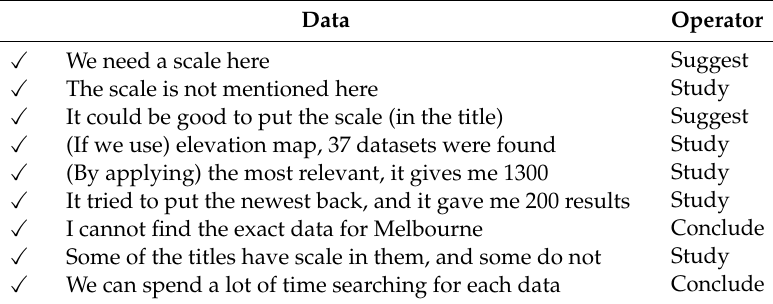
Table 5. Script analysis data for topographic